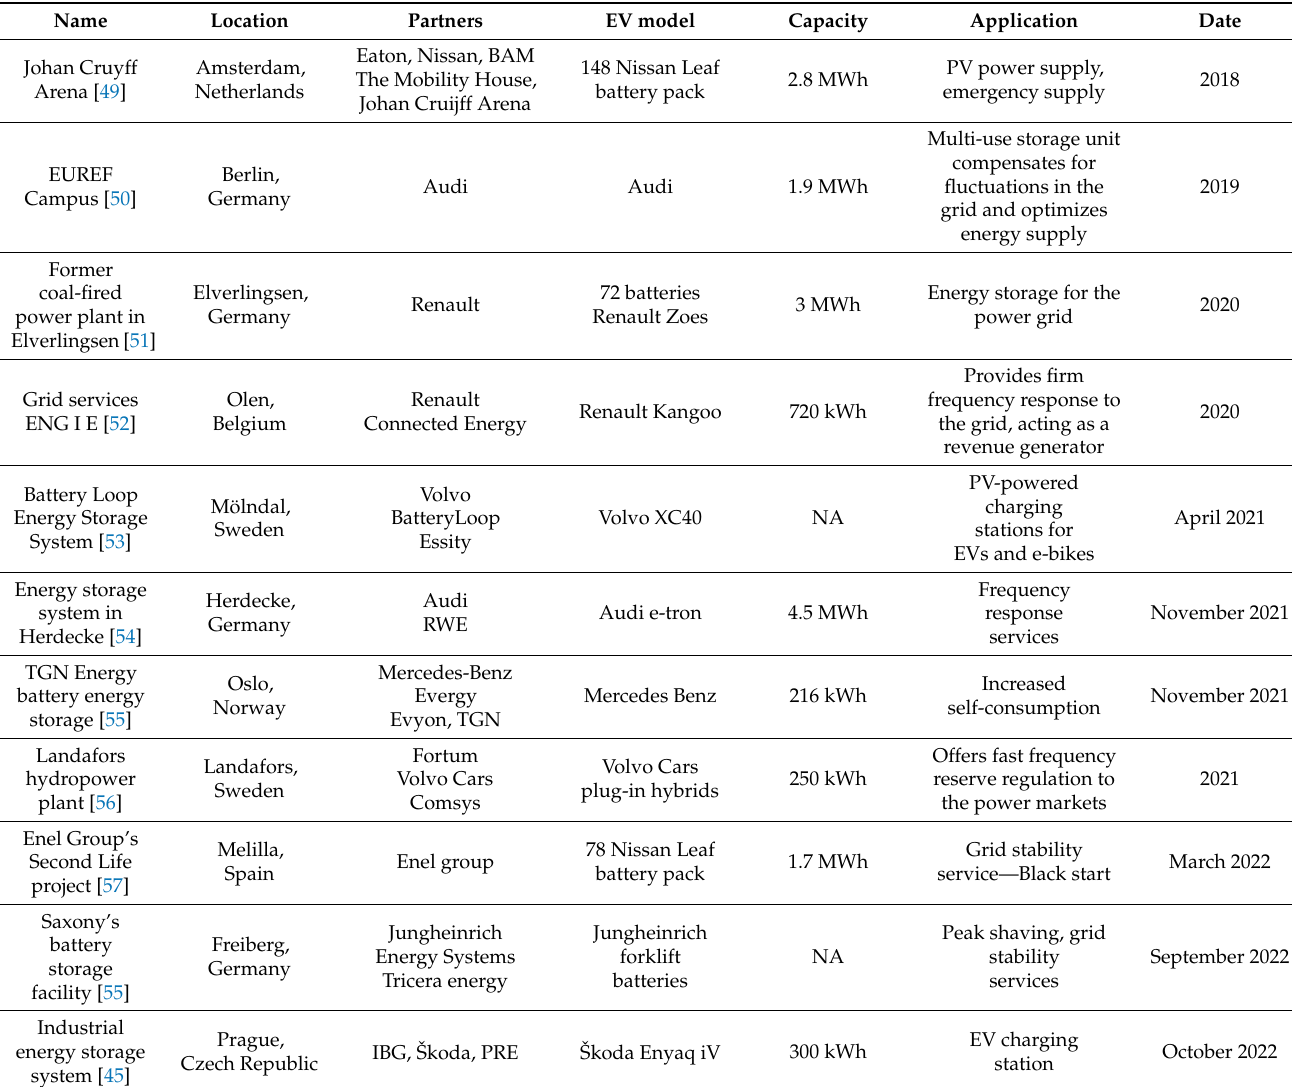
Table 1. Table 1. Recent second-life battery